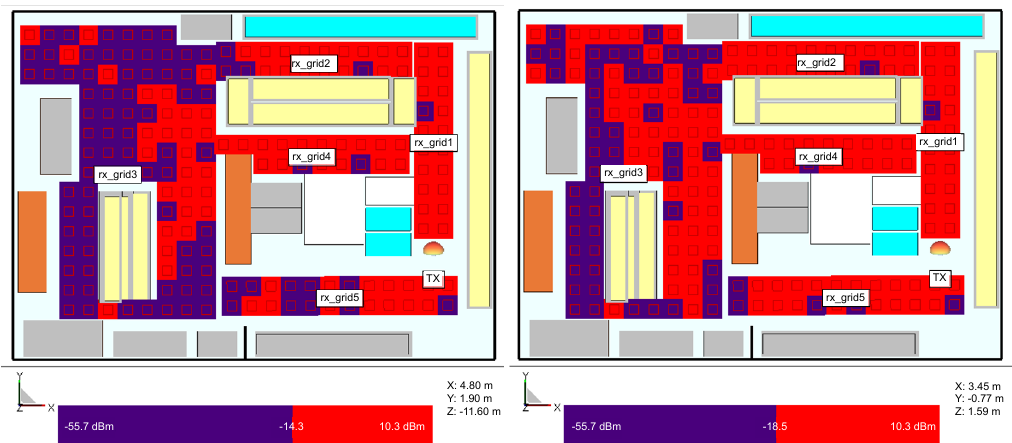
Figure 9. Power distribution for simulation model with mixed products and standalone tag, Higgs 2 ( left ) and Higgs 4 ( right ).